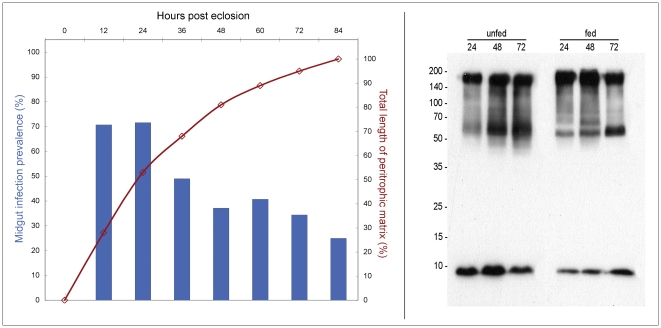
The parasite prevalence in infected teneral male G. m. morsitans compared to the mean length of the PM (graph) and an immunoblot of tsetse proventriculin 2 expression (Pro2).The graph depicts midgut infection data (derived from Figure 3) plotted on the y-axis (left) and the mean length of the PM (converted to a percentage of the fully formed length) derived from Lehane and Msangi [30] on the y′-axis (right). The fly age (h.p.e.) is represented on the x-axis. The red line indicates the formation of the PM over an 84 hour time course. The blue bars show the gradual decline in trypanosome prevalence with fly age. The midgut infection rates are inversely proportional to the length of type II PM secreted by the proventriculus. The Western blot illustrates the differential expression of midgut protein Pro2 in teneral unfed flies (aged 24 h.p.e., 48 h.p.e. or 72 h.p.e) and fed flies (24, 48 or 72 hours post bloodmeal). Fed flies received a bloodmeal at 24 h.p.e. and were dissected at 24 hour intervals. Half of a midgut equivalent (from a pool of five) was loaded per lane and detected with mAb 4A2, a monoclonal antibody that recognizes tsetse Pro2.